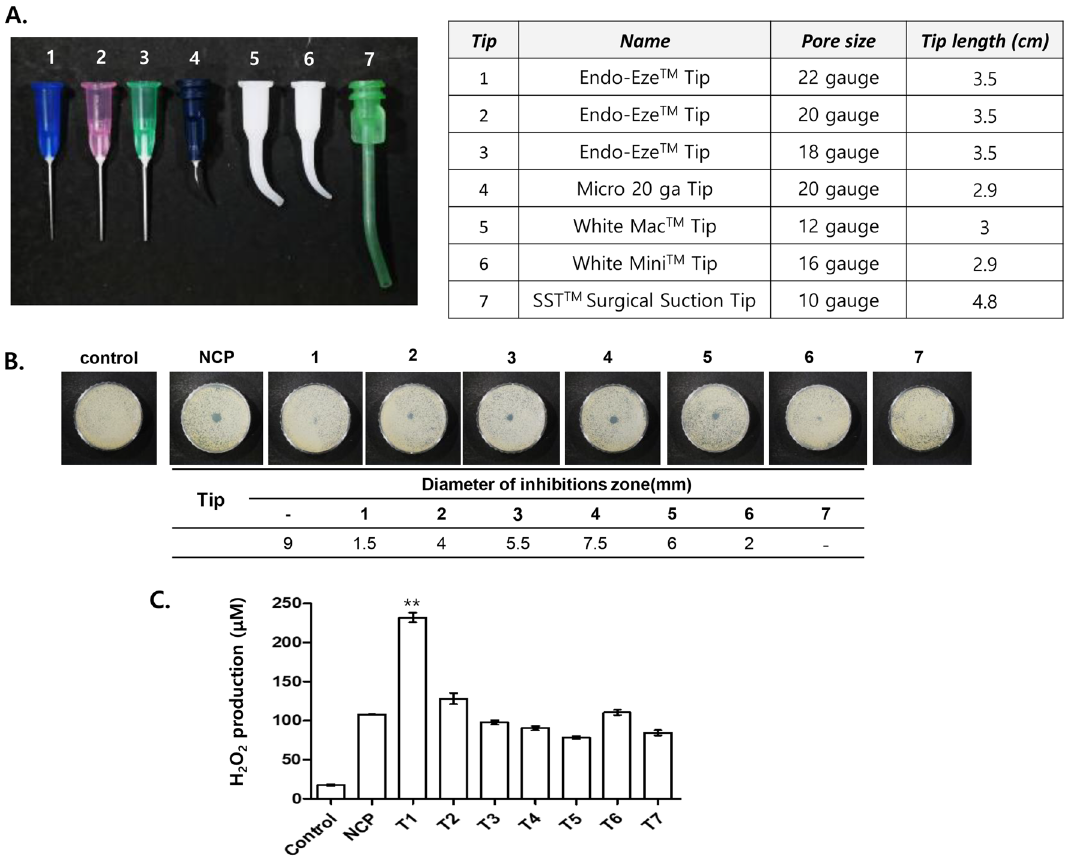
Figure 9. The bactericidal effect of NCP mounted with dental tips is dependent on the pore size and the length of tips. ( A ) Total 7 kinds of dental tips that can be mounted on NCP device were prepared. Left panel a photograph showing the appearance of 7 tips. Right panel a table showing specific information of the tips. ( B ) S.mutans samples on solid medium were subjected to NCP treatment for 5 min in unmounted or mounted with 7 kind of tips respectively. Upper panel A photographs showing a clear zone formed by 5 min of NCP treatment. Bottom panel : a graph showing the size of a clear zones. ( C ) The H 2 O 2 level change of 2 ml of liquid medium after NCP treatment mounted with 7 kinds of dental tips. Data shown are the average of three independent experiments, **<